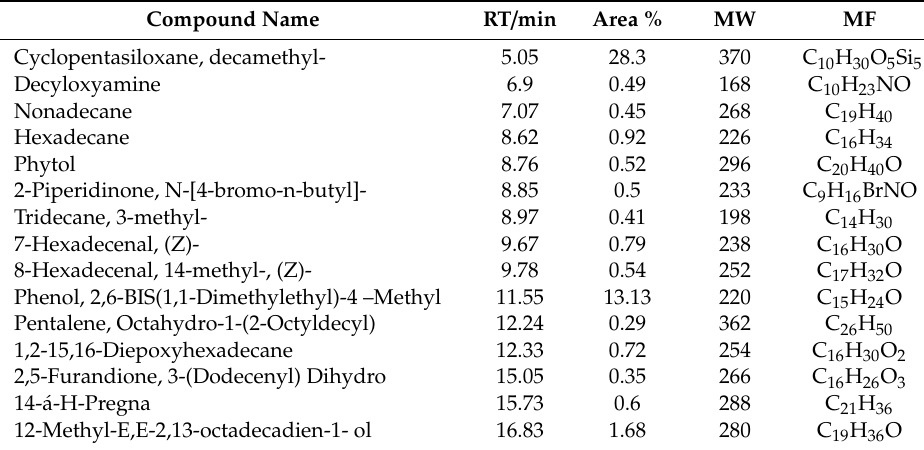
Table 1. The phytochemical compositions of argan